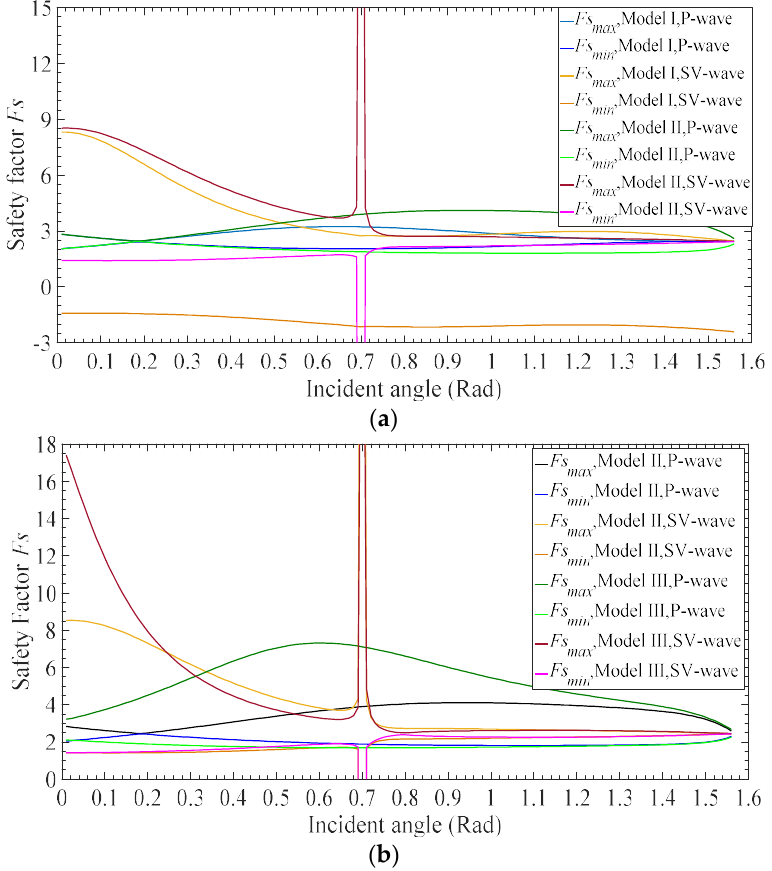
Figure 8. Instantaneous safety factor vs. wave incident angle: ( a ) comparison between models I and II; ( b ) comparison between models II and III.